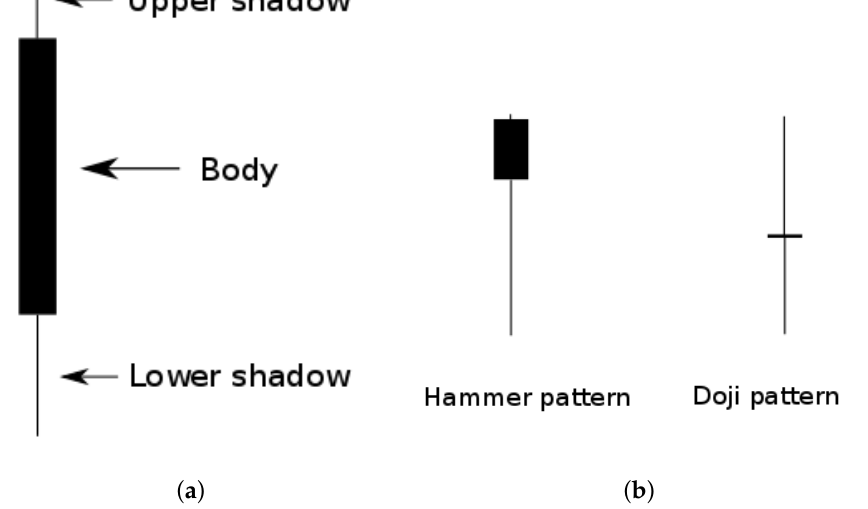
Figure 2. ( a ) Different parts of a bearish candlestick. ( b ) A doji is a kind of candlestick where the size of the body is much smaller than both shadows, while a hammer has a small body, one small shadow, and one big shadow (depending on whether we are referring to an inverted hammer or